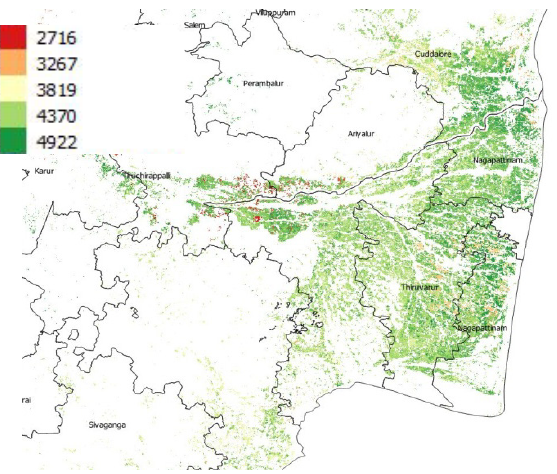
Fig. 3. Rice Yield map 2017-18- Cauvery Delta The validation of the spatially generated rice yield was carried out in 100 locations of Tiruvarur district by comparing with the observed yield. At the monitoring sites the agreement was found to be from 81 to 96 per cent with the mean agreement of 86.2 per cent for rice yields. The average errors as computed by RMSE and NRMSE were 403.9 kg ha-1 and 13.8 per cent respectively.